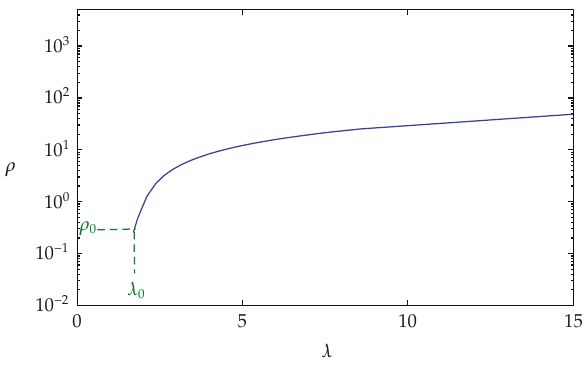
Figure 11: Graph of λ versus ρ for β (cid:3)